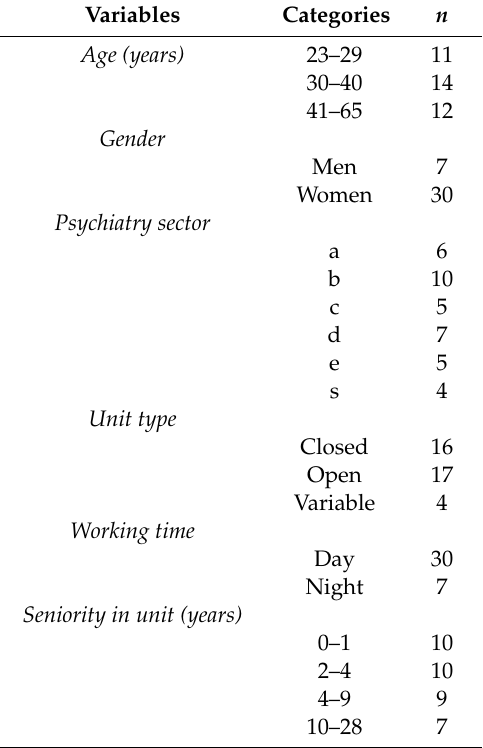
Table 1. Characteristics of the 37